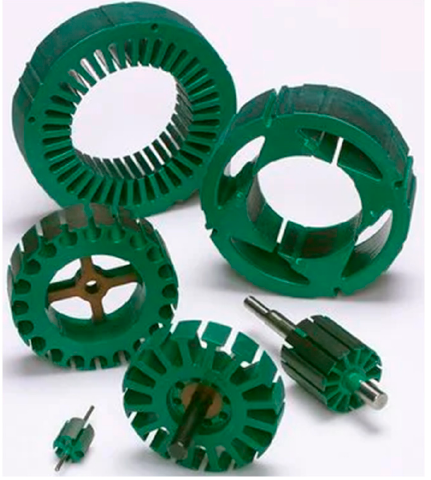
Figure 3. An example of coating a core with epoxy resin [14].